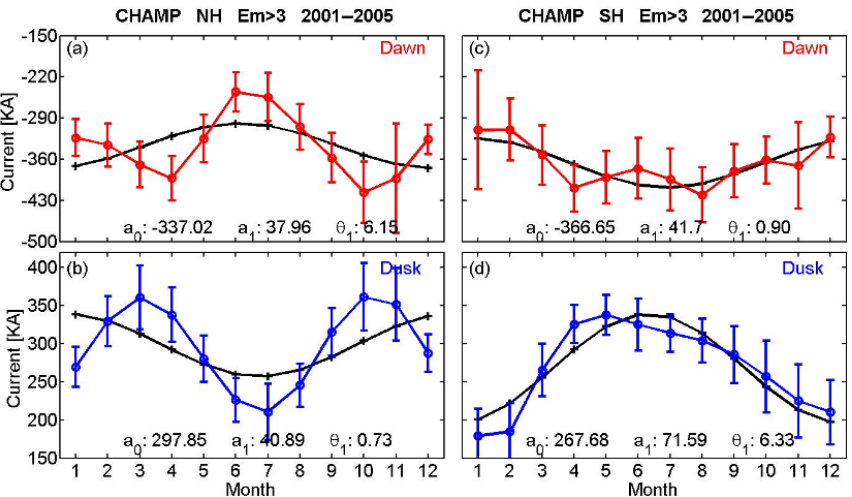
Figure 6. The seasonal variation of eastward net currents. Presented are dawnside (a, c) and duskside (b, d) currents derived from high- latitude passes over the Northern Hemisphere (a, b) and Southern Hemisphere (c, d) . Vertical bars represent the uncertainty of the monthly means. Black curves are sinusoidal fits to the observations. In each panel the constant term, a 0 , annual amplitude, a 1 (both in kA), and the phases of the peaks, θ 1 (in months), are